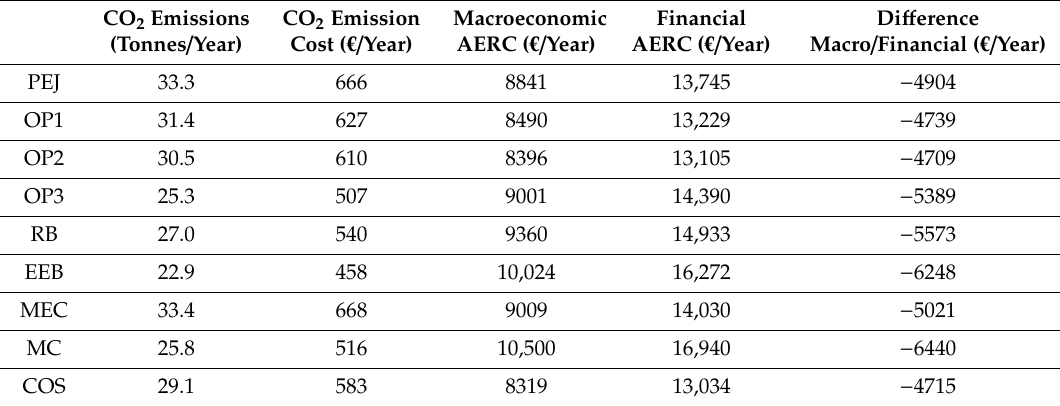
Figure 5. Annualized energy-related costs against primary energy demands for the more representative EEMs analyzed for the warmer climatic zone B, including a macroeconomic projection. Table 12. CO 2 emissions and corresponding cost for the EEMs considered and comparison between the annualized energy-related costs (AERC) determined for the financial and macroeconomic projections in the warm